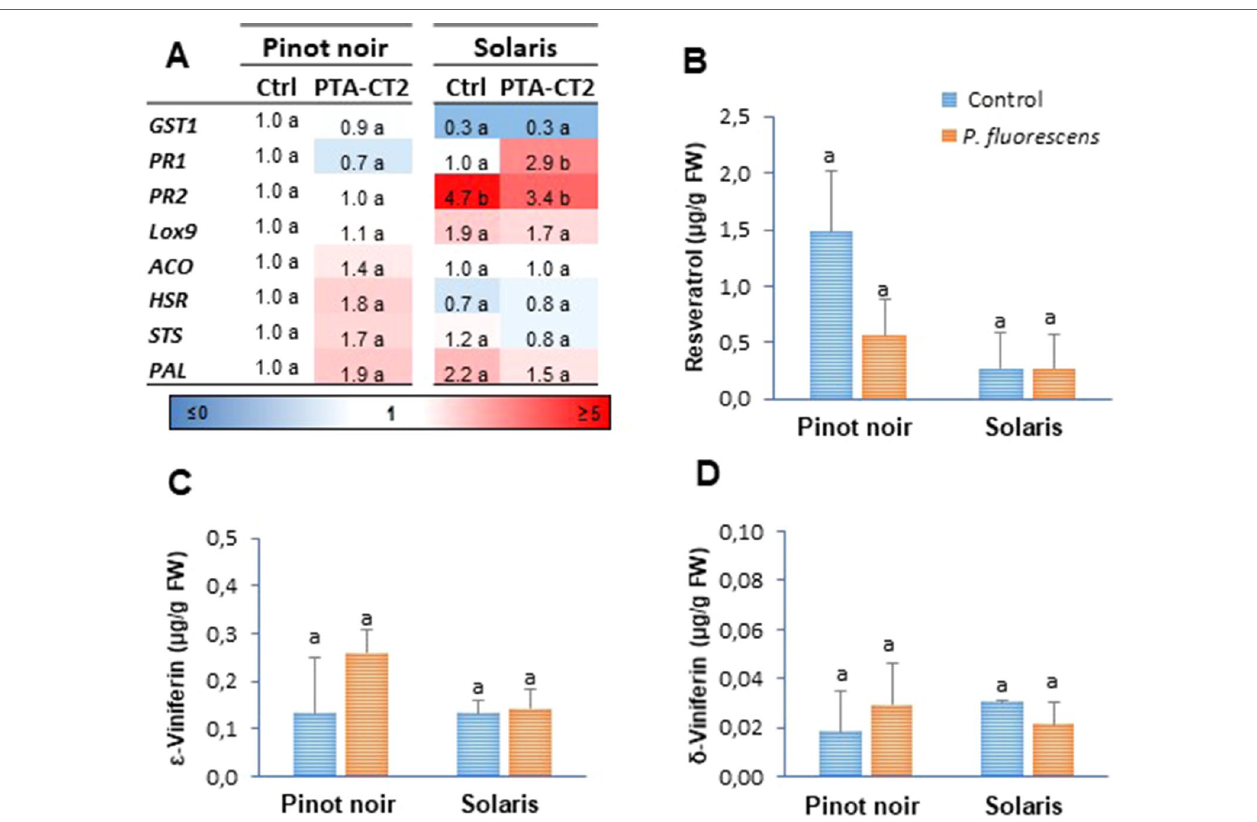
FIGURE 1 | Pseudomonas fluorescens PTA-CT2 has no effect on the basal expression of defense-related genes and phytoalexin production in the leaves of grapevine cultivars Pinot noir and Solaris. Plants from each cultivar were treated at the root level with P. fluorescens at 10 7 CFU g −1 of soil, and 2 weeks later, the transcript level of defense genes (A) and the amounts of resveratrol (B) , ε -viniferin (C) , and δ -viniferin (D) were quantified. For gene expression, uninfected control of Pinot noir was considered as the reference sample (1× expression level) for both cultivars, and heatmaps represent changes in transcript expression levels as indicated by the color shading. GST1 , glutathione S-transferase 1; PR1 , pathogenesis-related protein 1; PR2 , β -1,3-glucanase; LOX9 , lipoxygenase 9; ACO , 1-aminocyclopropane-1-carboxylic acid oxidase; HSR , hypersensitive related; PAL , phenylalanine ammonia-lyase; STS , stilbene synthase. Data are the means of three independent experiments performed in 2016, and vertical bars indicate standard deviation. Different letters indicate statistically significant differences between the treatments (ANOVA Tukey test, P <